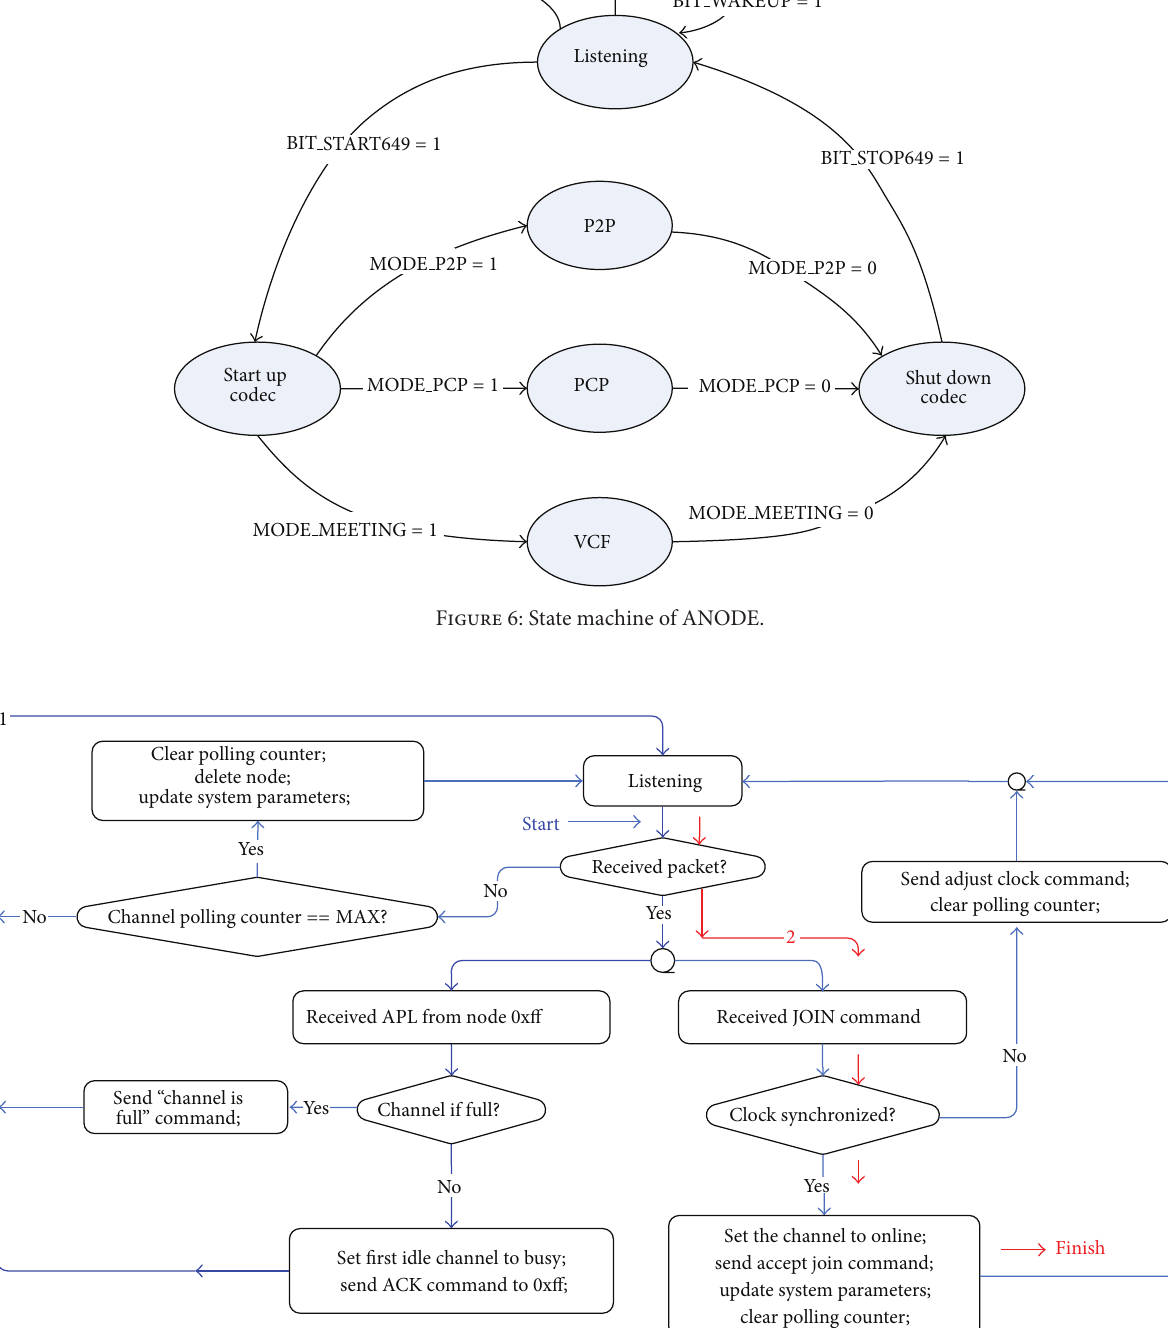
Figure 7: Simplified flowchart of node joining-CNODE